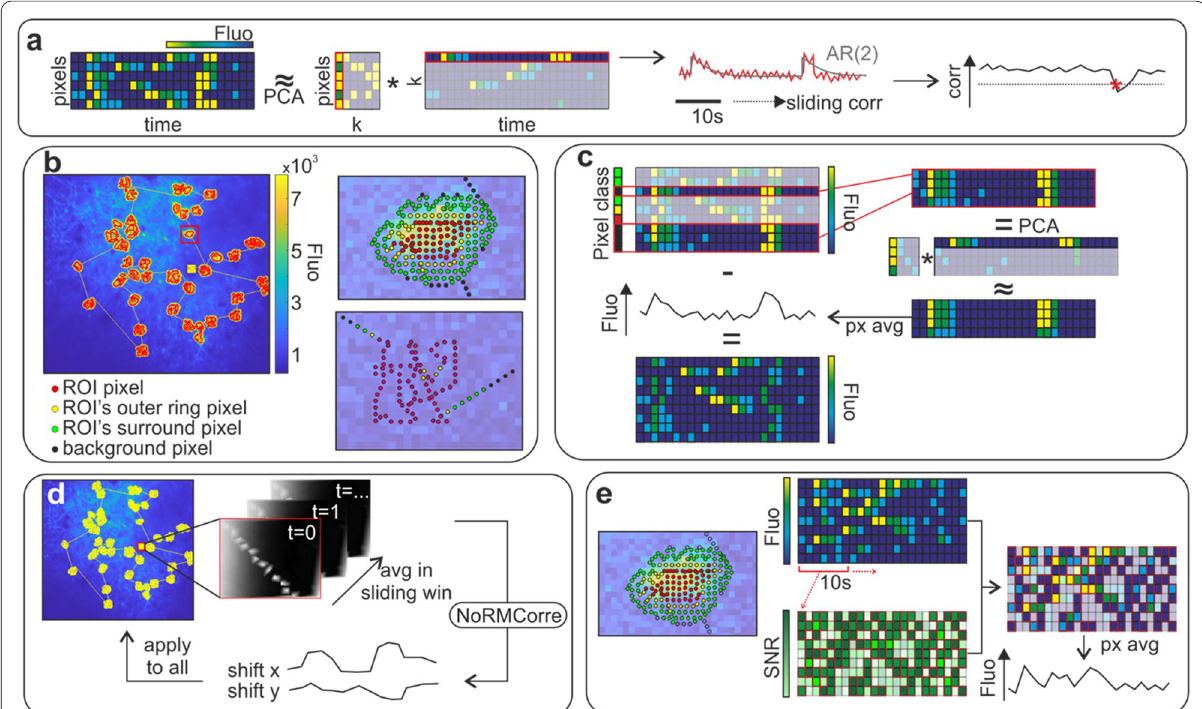
Fig. 2 Schematic of the processing algorithms. a Schematic of the algorithm for large artefacts detection. The dimensionality of SLS data is reduced using PCA and the PC1 scores vector is fitted using an autoregressive model of second order (AR(2)). If the sliding correlation (computed in a 10 s window) between the PC1 scores vector and its fit drops below a given threshold (set to 0.3), a large artefact is detected (red star). b Left: an SLS trajectory (yellow line) with a surround of 4 pixels is overlapped to a projection of the corresponding raster acquisition and its reference segmentation (red ROIs). A reference box (yellow square) is scanned at the end of the SLS trajectory. Right top. Pixels assignment for an example ROI (red box in left panel). Pixels can be assigned to the ROI (red dots), to its outer ring (yellow dots), to its surround (green dots), or to background (black dots). Right bottom. Pixels assignment for an example ROI of a SLS trajectory without ROIs surround. c Schematic of the algorithm for background activity subtraction. A 1-rank representation of the fluorescence activity of trajectory pixels labelled as background (black pixels) is computed using PCA. The across-pixels averaged low-rank representation is considered as a proxy of background activity, multiplied by 0.7 and subtracted from the fluorescence of all the pixels. d Schematic of the small and local artefacts correction algorithm based on NoRMCorre. Activity recorded from the reference box (optionally smoothed in time by averaging in a sliding window of arbitrary width) is considered as a raster acquisition to estimate planar displacement using the NoRMCorre algorithm [44]. The estimated displacements are then applied back to the full trajectory. e Schematic of the small and local artefacts correction based on SNR. For each ROI, pixels labelled as belonging to the ROI, its outer ring or its surround are considered. In a sliding window of 10 s the SNR of each pixel is computed, pixels are sorted for decreasing SNR, and only a fixed number of high-SNR pixels is used to extract the fluorescence activity. Pixels are selected line-by-line considering the SNR computed in the subsequent 10 s